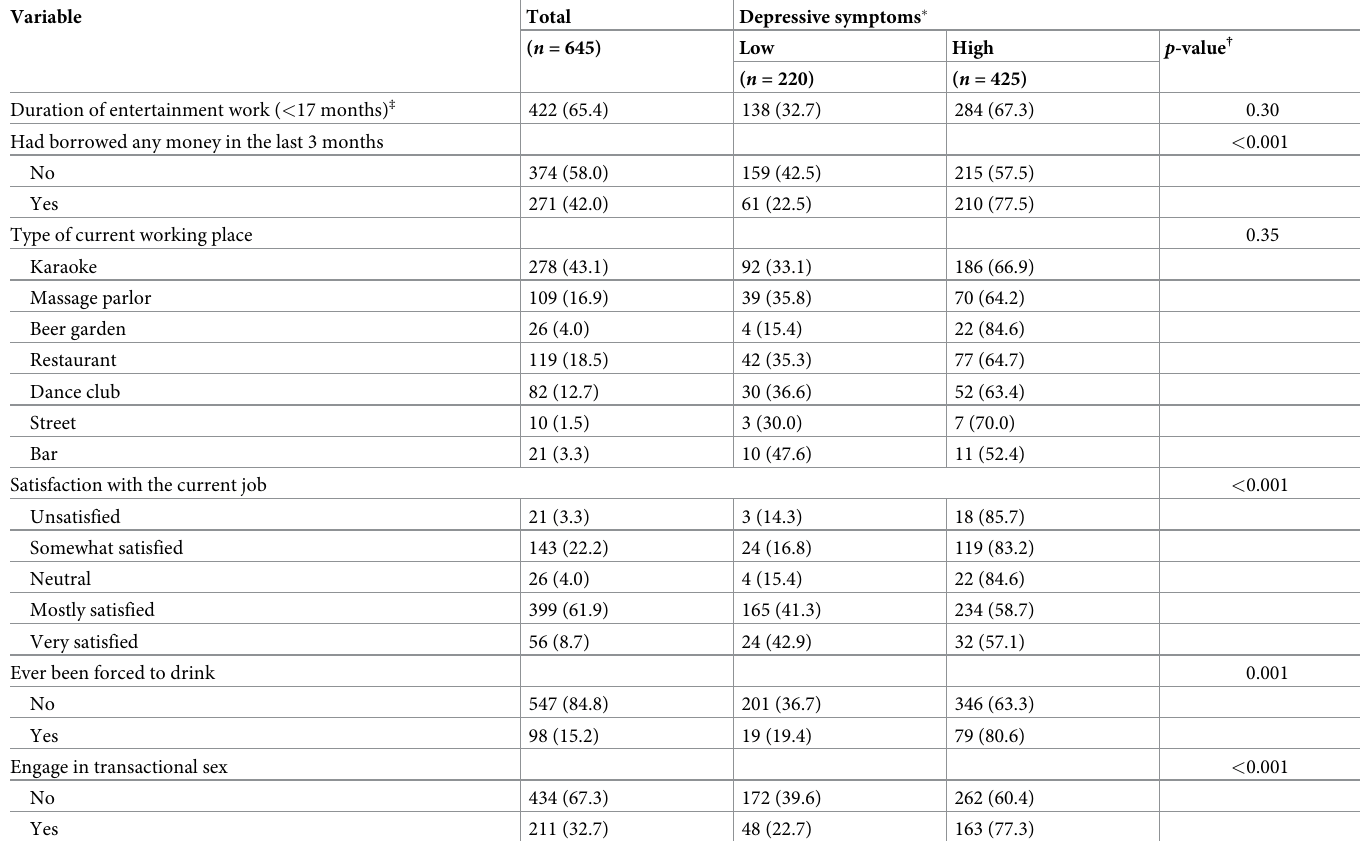
Table 2. Comparison of entertainment and sex work of FEWs with low and high levels of depressive symptoms ( n =